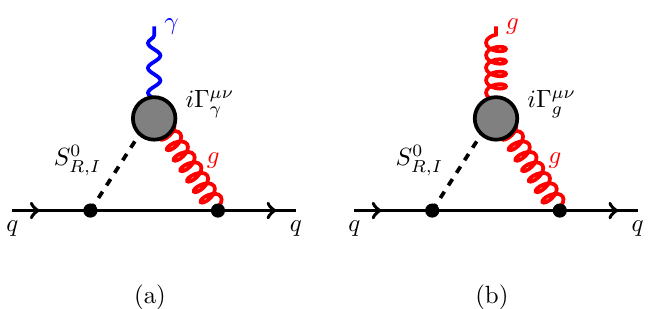
Figure 13 . Second loop of the Barr-Zee contributions to the quark EDM (a) and CEDM (b). diagrams. The effective vertex of the dominant contributions to the (C)EDM, and the corresponding scalar form factors, read ~q, µ, b